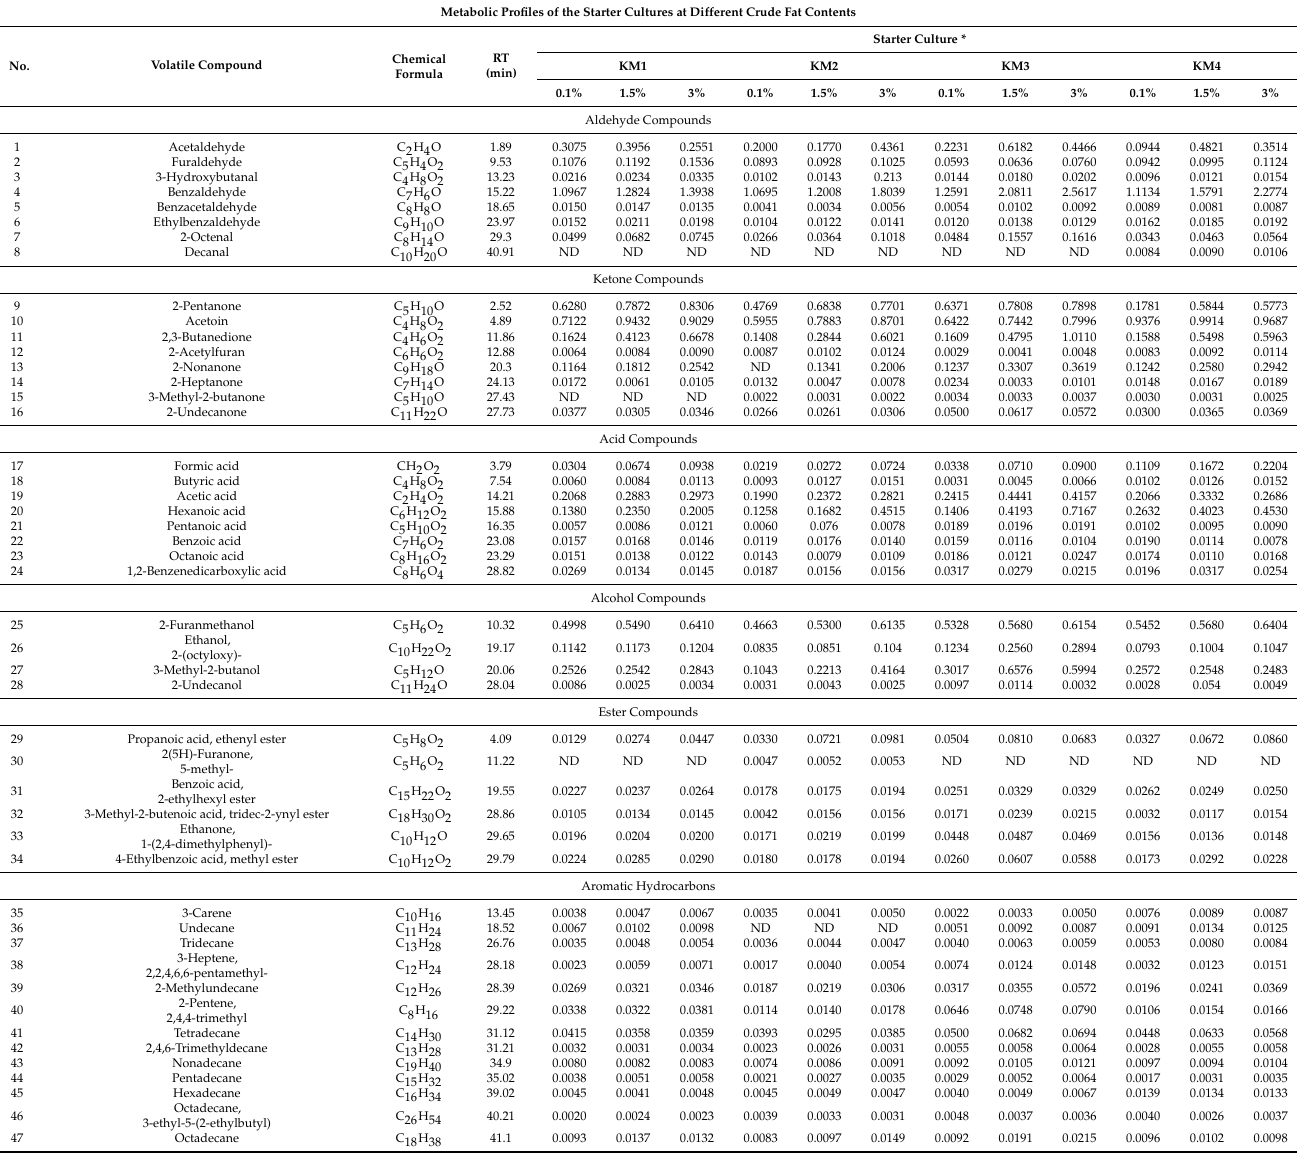
Table 5. Influence of crude fat content on the metabolic profiles of symbiotic starter cultures KM1, KM2, KM3, and KM4.